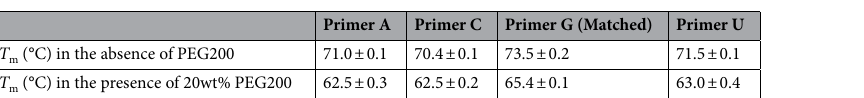
Table 3. Melting temperature of primer and template